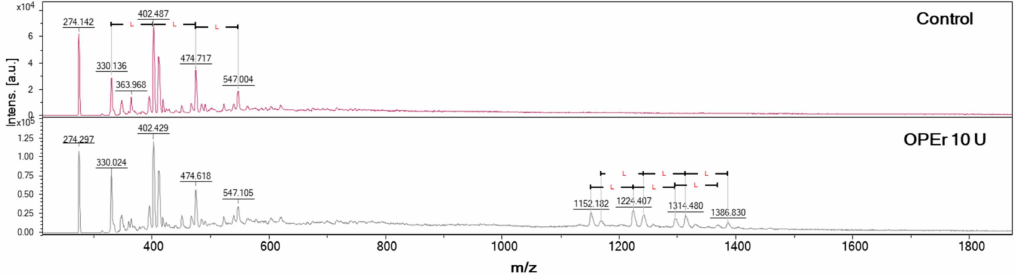
Figure 7. Synthesis of L -PLA by polycondensation of lactic acid catalyzed by OPEr. MALDI-TOF spectra of the chloroform-soluble material extracted from the reaction mixture. The upper plot corresponds to a control reaction without enzyme, and the lower to a reaction with 10 U of enzyme. L represents the incorporation into the chain of one LA unit (72